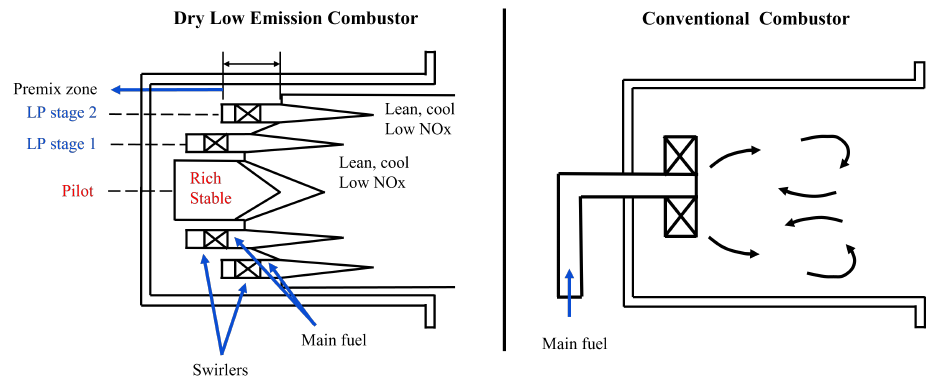
Figure 15. DLE and conventional combustor.